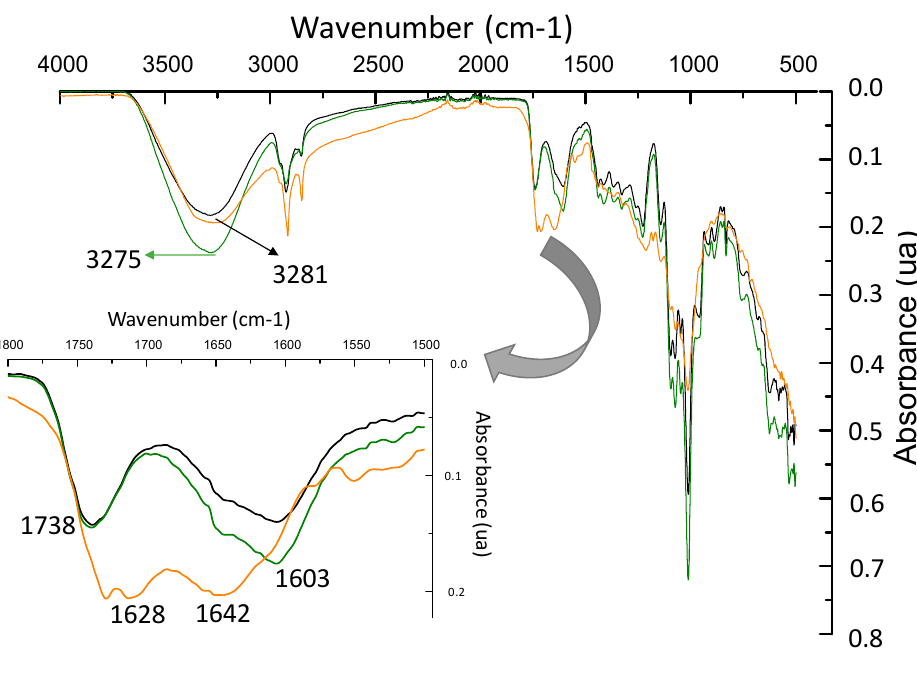
Figure 4. FTIR spectra of PC (------) and PC-5E (------) films and CBSE-2 (------).